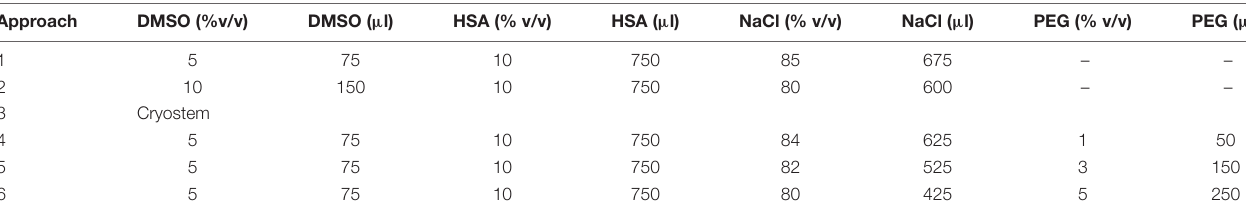
TABLE 1 | Composition of freezing